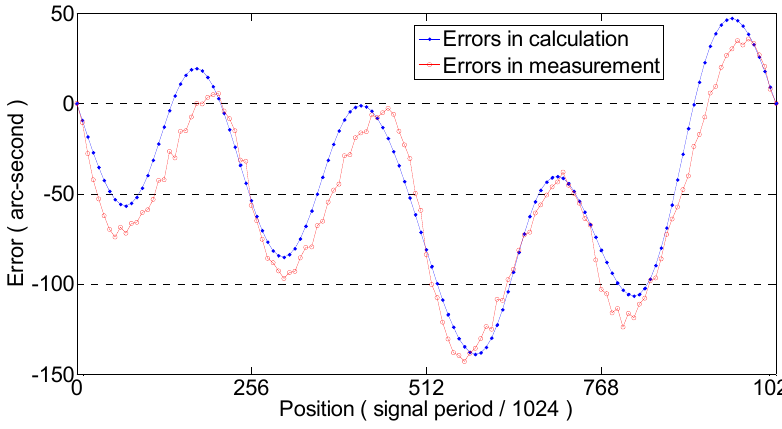
Figure 7. Subdivision error of encoder.